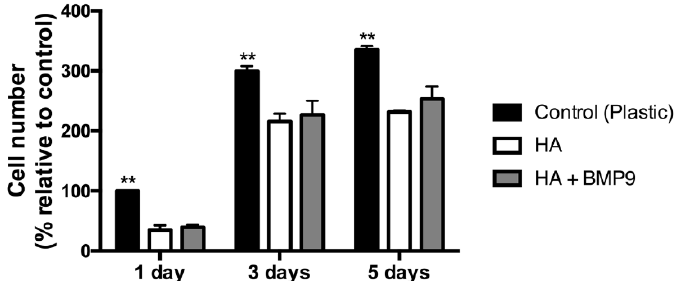
Figure 3. Proliferation assay at one, three and five days post-seeding of ST2 cells seeded on (1) control tissue culture plastic (TCP), (2) control HA and (3) HA in combination with 100 ng/mL of rhBMP9. The highest cell numbers were found on control TCP with no differences observed between HA with/without rhBMP9 (** denotes significantly higher than all other treatment modalities, p < 0.05).